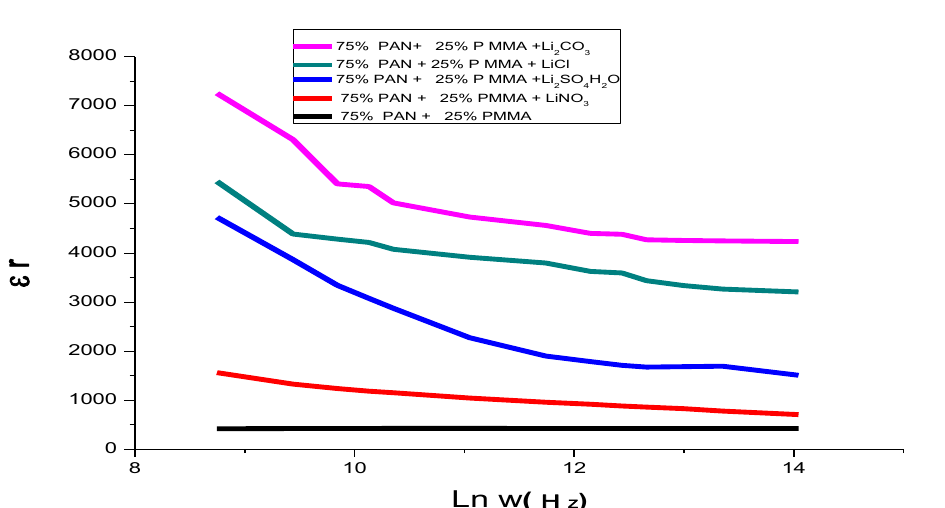
, LiCl, Li CO , and Li SO H O). 3 2 3 2 4 2